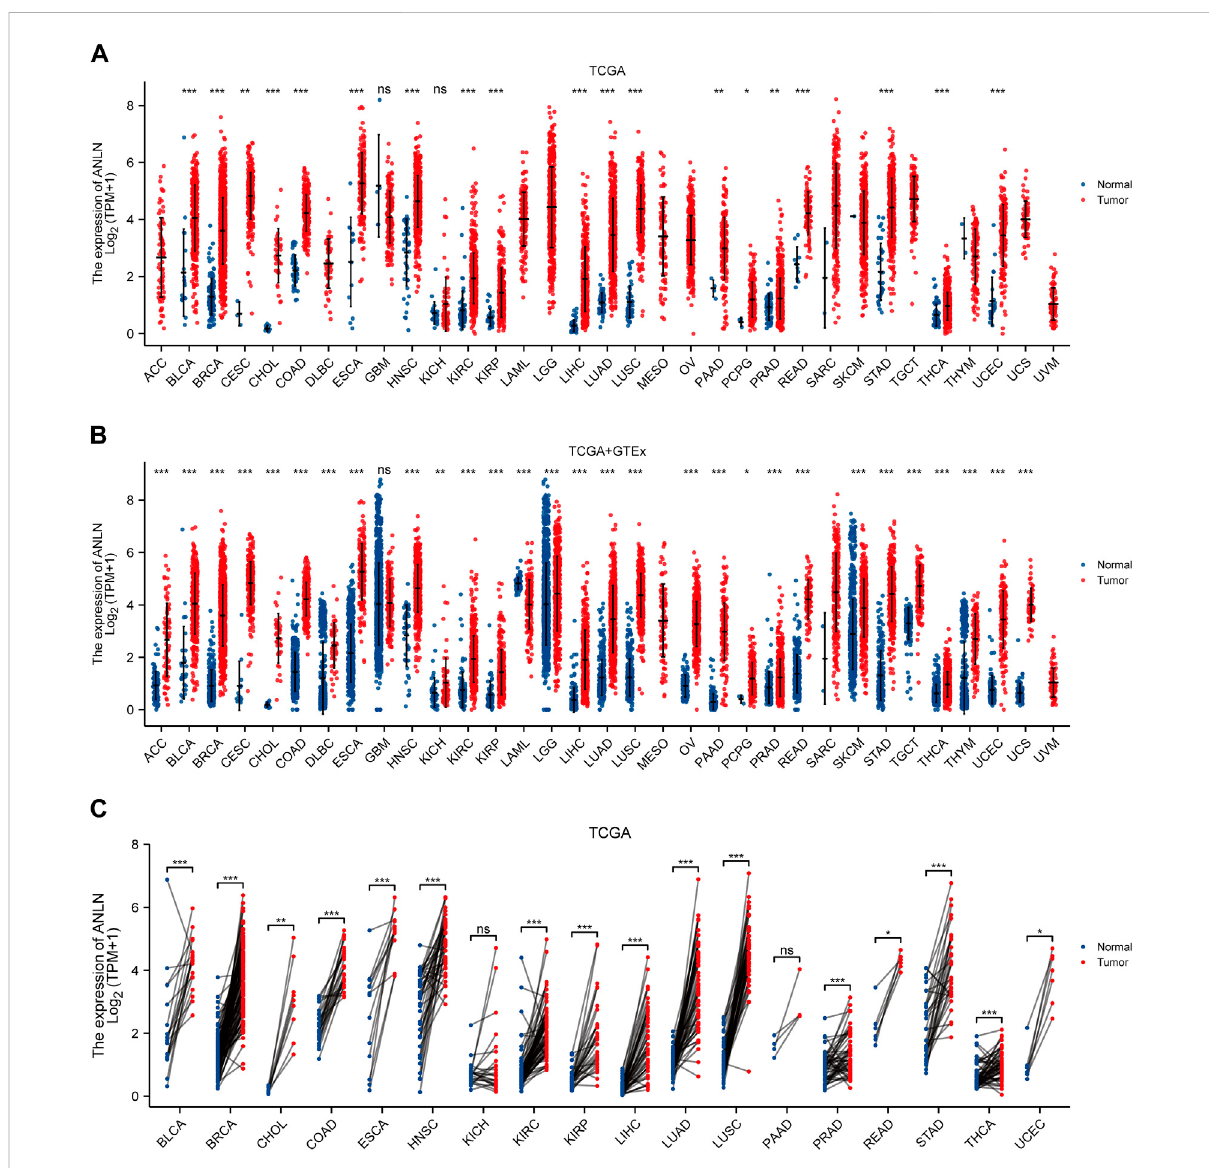
FIGURE 1 ANLN mRNA expression in tumor and normal tissues. (A) ANLN mRNA expression difference between TCGA tumor and normal tissues. (B) ANLN mRNA expression difference between tumor and normal tissues with data from the TCGA and GTEx. (C) ANLN mRNA expression in TCGA tumor and paired normal tissues (* p < 0.05, ** p < 0.01, *** p <